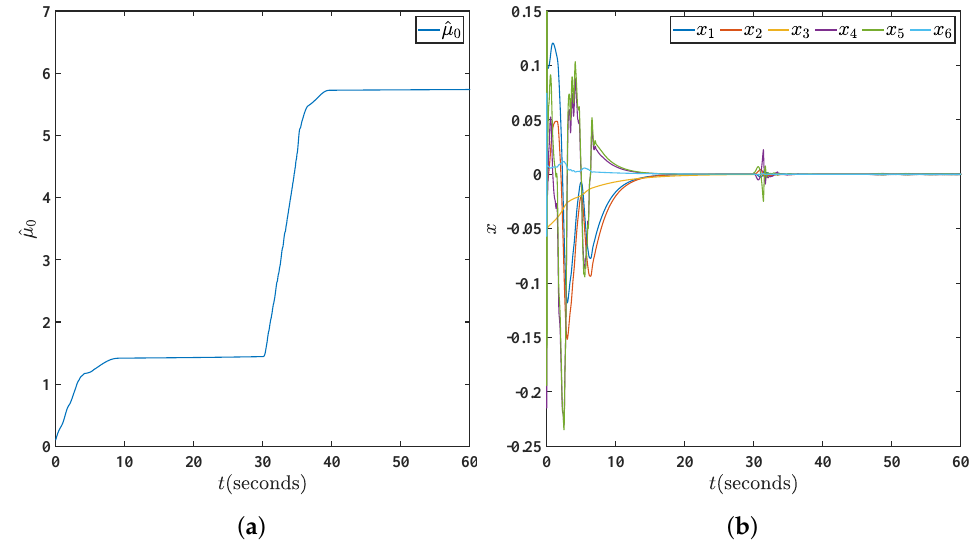
Figure 9. ( a ) Responses of parameter ˆ µ 0 ( t ) using the proposed methodology in fault case with ρ 3 = 0, σ 3 = 1, ρ 5 = 0.6. ( b ) System responses x ( t ) using the controller developed in this paper with different dominant wave strength coefficient, damping coefficient, and wave encounter